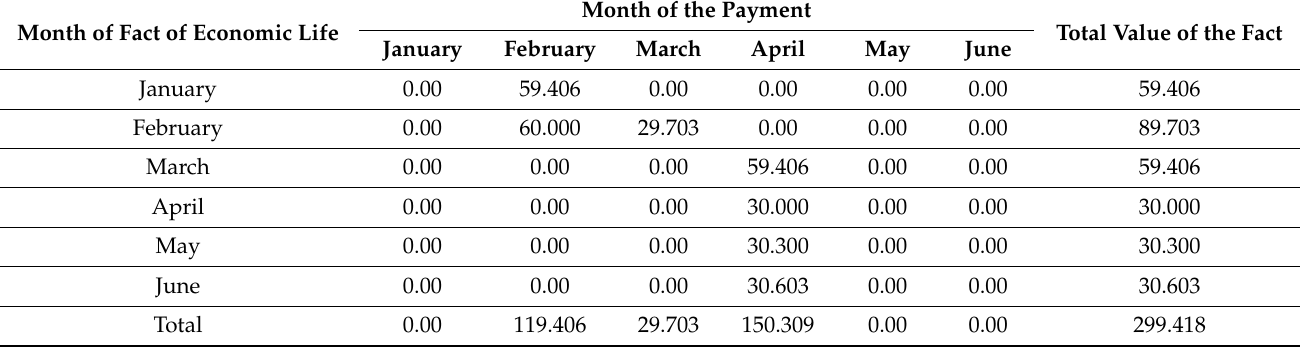
Table 4. Discounted (accrued) value of payments involved in determining value of the fact (FPFS), thousand $.